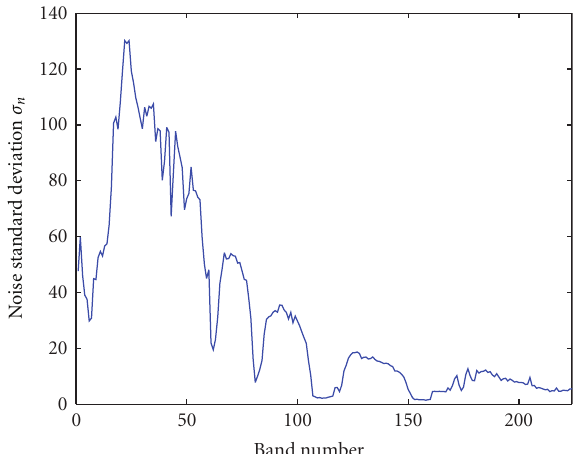
Figure 3: Measured noise standard deviation of AVIRIS 1997 radi- ance data.